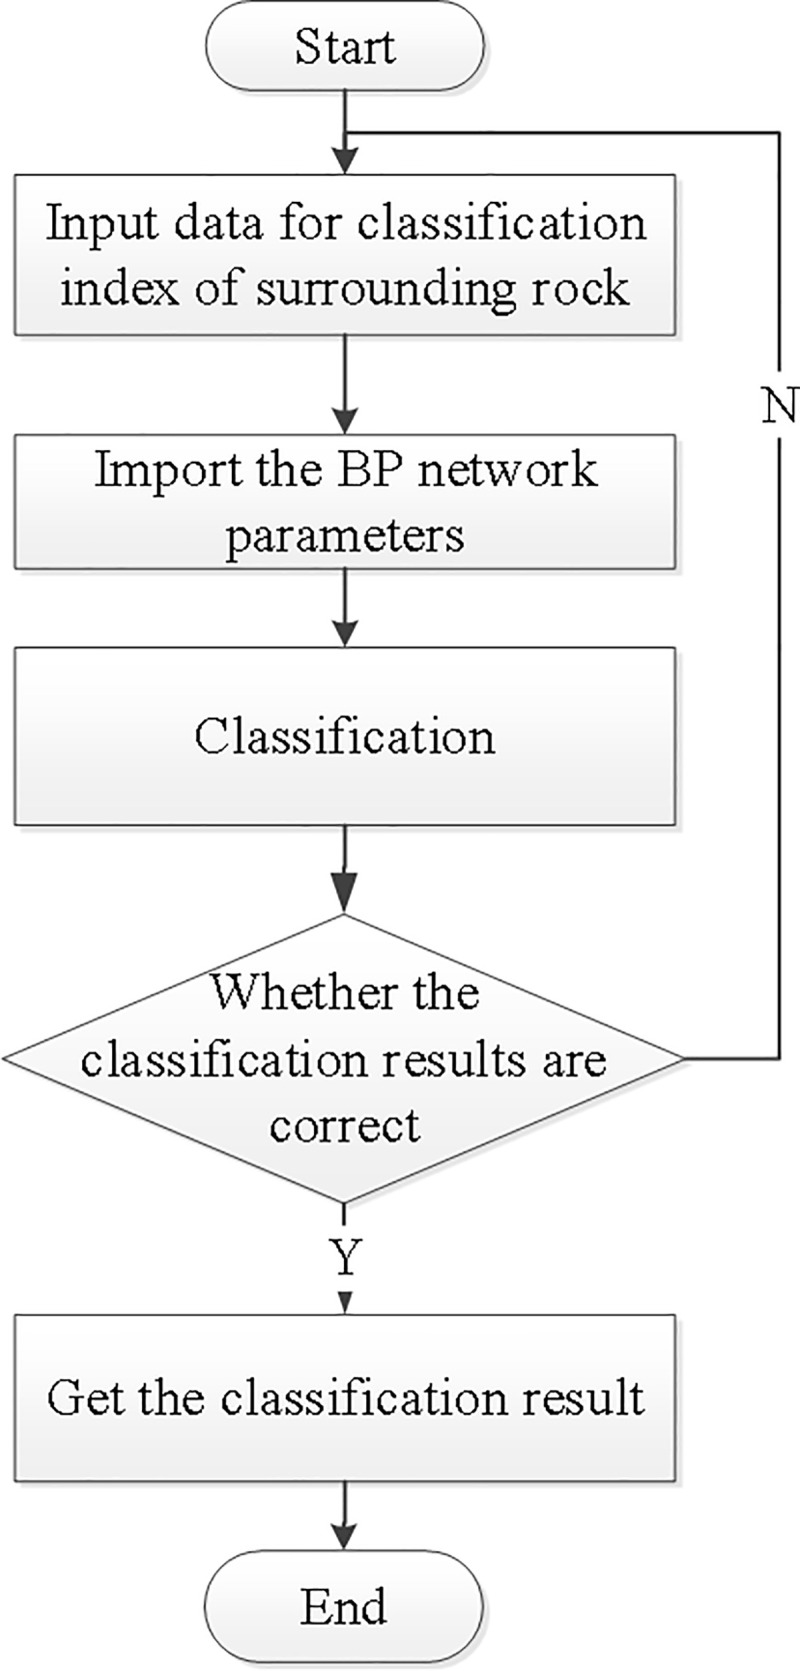
Flow chart of stability classification module of surrounding rock.